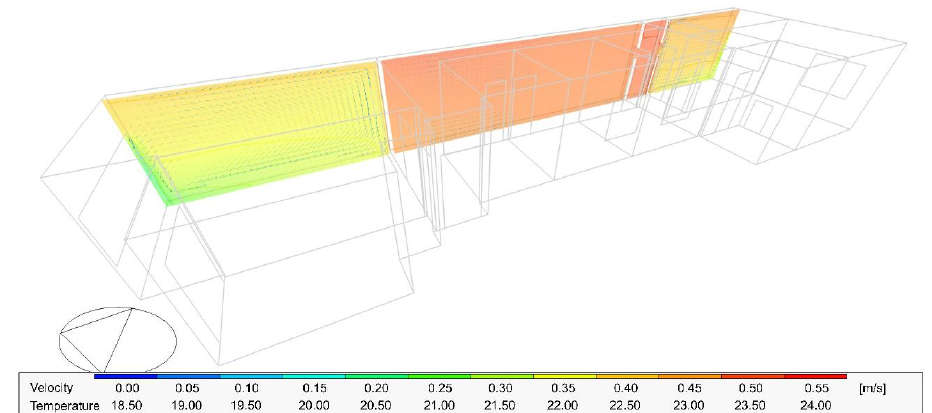
Figure 12. Loft flat. Q R _2.1_0.15. Longitudinal section. CFD using Design Builder, 1 August 2014 3 p.m.